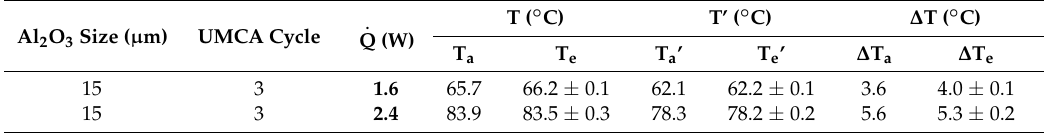
Table 6. Effects of the heat input power when comparing the temperatures obtained from the analytical model (all with subscript a) and the experiment (all with subscript e), using the 15 µ m Al 2 O 3 powders for three UMCA cycles and under two total heat input power